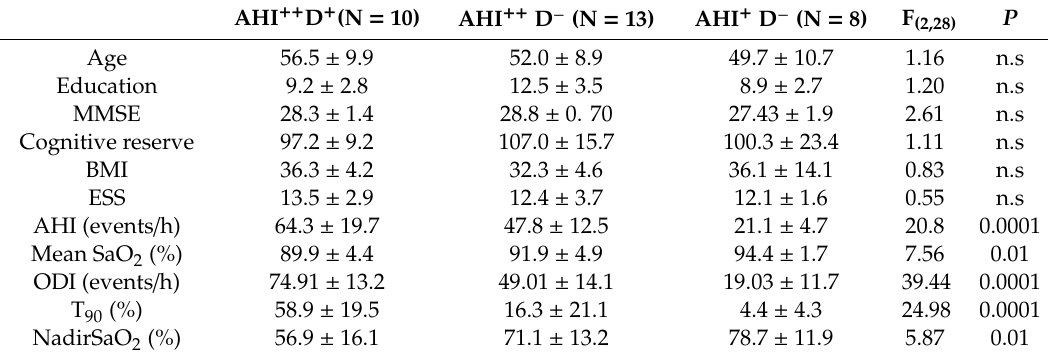
Table 4. Classification of OSA patients as a function of apnea-hypopnea index (AHI) and desaturation severity. AHI ++ , severe OSA and AHI + , moderate OSA. AHI ++ AHI + Desaturators (D + ) 10 1 Nondesaturatos (D − ) 13 8 Table 5. Mean (and standard deviation) of demographic and clinical data for three groups of OSA